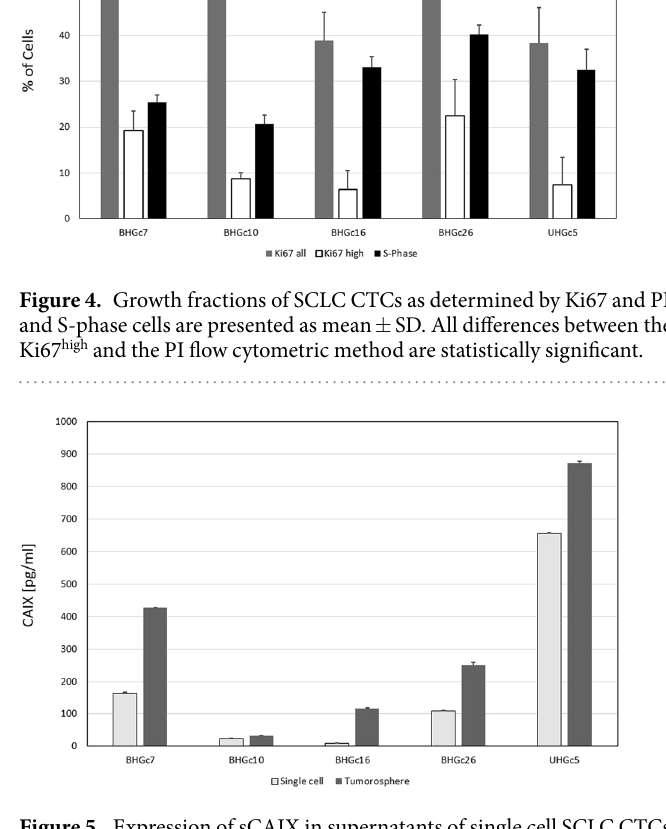
Figure 5. Expression of sCAIX in supernatants of single cell SCLC CTCs and tumorospheres. CTC cell lines were cultivated for one week and sCAIX was determined in supernatants using an ELISA assay. Values are shown as mean ± SD. All differences between single cells and tumorospheres are statistically